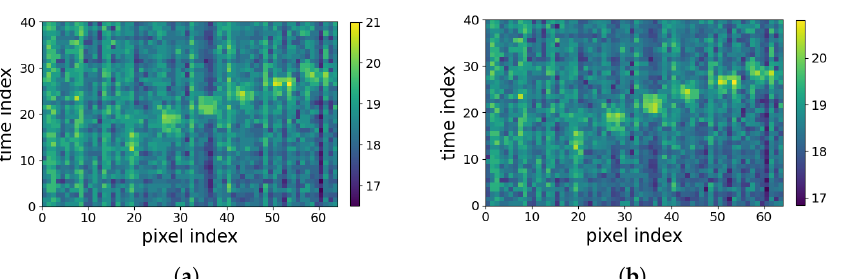
Figure 10. Illustration of ( a ) an original 2D spatiotemporal map with horizontal and vertical periodic noise; ( b ) noise-reduced 2D map using the proposed